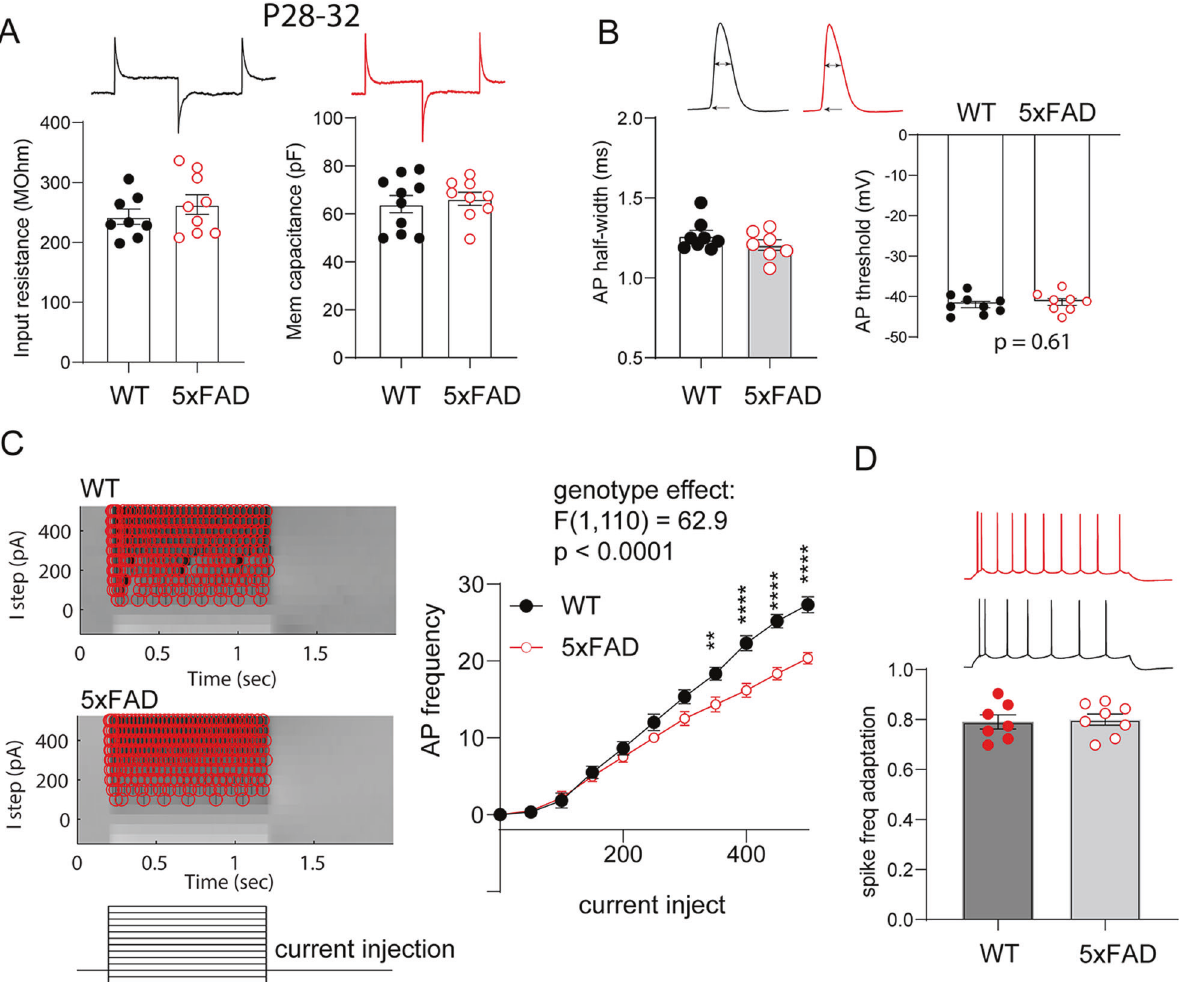
Fig. 3 Reduced intrinsic excitability of VC-L5 neurons in P28 – 32 5XFAD mice. A VC-L5 neurons from 5XFAD brain slices show similar membrane input resistance (WT, n = 8 cells/5 mice; 5XFAD, n = 9 cells/6 mice. t 15 = 0.96, p = 0.35) and membrane capacitance (WT, n = 10 cells/5 mice; 5XFAD, n = 9 cells/6 mice. t 17 = 0.48, p = 0.63) compared to WT littermate L5 neurons. Representative current responses to voltage steps are on the top , based on which membrane properties are calculated. B VC-L5 neurons from 5XFAD mice exhibit similar action potential half-width (WT, n = 8 cells/5 mice; 5XFAD, n = 7 cells/6 mice. t 13 = 1.22, p = 0.25) and AP threshold (WT, n = 9 cells/5 mice; 5XFAD, n = 8 cells/6 mice. t 15 = 0.53, p = 0.61). C Representative action potential density plot from 5XFAD and WT VC-L5 neurons. Intrinsic excitability responses, measured by AP fi ring in response to current step injections ( − 100 to 500pA, with 50pA increment), was shown to the right . VC-L5 neurons from 5XFAD slices show reduced AP number in response to current injections (WT, n = 6 cells/5 mice; 5XFAD, n = 6 cells/5 mice. Repeated measures two-way ANOVA, genotypes effects: F (1,10) = 9.6, p = 0.011). A signi fi cantly lower AP fi ring at higher current steps (350 – 500pA) was observed (Sidak ’ s post hoc multiple comparison test. ** p < 0.01, **** p < 0.0001). D 5XFAD VC-L5 neurons show similar spike frequency adaptation compared to WT neurons (WT, n = 7 cells/5 mice; 5XFAD, n = 8 cells/7 mice. t 13 = 0.26, p = (Fig. 6G. ND, n = 255 units/8 mice; MD, n = 191 units/7 mice. single unit. We found that 4-day MD shifts the ODI distribution p = 0.49, K-S test). In addition, MD had no signi fi cant effects in the curve to the right in WT mice (Fig. 6D. None-deprived/ND, n = 225 5XFAD mice compared to ND mice on CBI scores (Fig. 6H. ND, units/7 mice; deprived/MD, n = 198 units/7 mice. p = 0.007, K-S 0.66 ± 0.016, n = 8 mice; MD, 0.64 ± 0.032. n = 7 mice. t 13 = 0.68, test on cumulative curve distribution). We then calculated the contralateral bias index (CBI) for each mouse based on the ODI p = 0.51). MD also had no signi fi cant effects on the ODI scores from all single units, and found that MD in WT mice leads to distribution across these seven categories (Fig. 6I. ND, n = 255 signi fi cantly reduced CBI scores in control mice (Fig. 6E. WT mice units/8 mice; MD, n = 191 units/7 mice. p = 0.85, K-S test). CBI scores: nondeprived/ND, 0.67 ± 0.017; monocular deprived/ MD, 0.54 ± 0.019. t 12 = 4.59, p = 0.0006). The calculated ODI values were further assigned to the 1 – 7 seven-category scheme [32, 34].